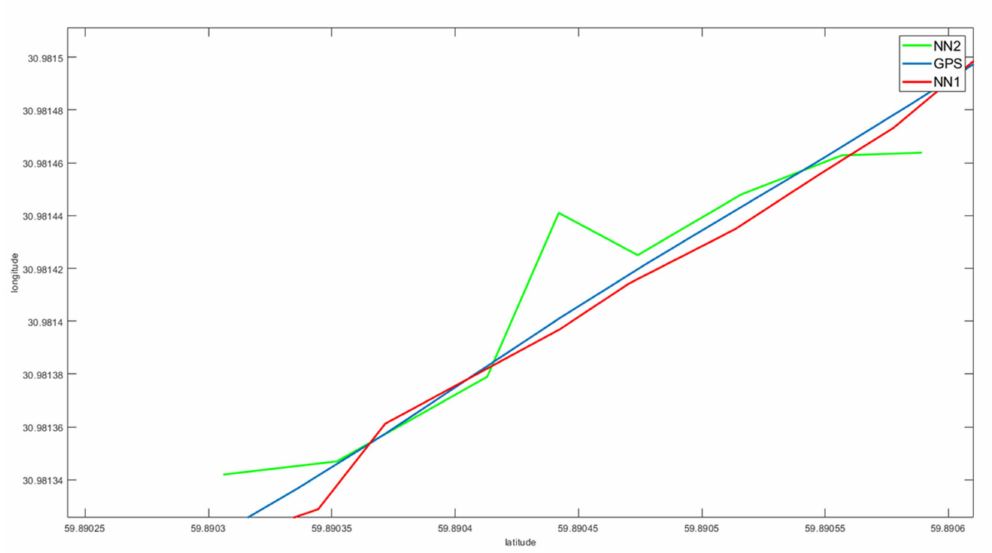
Figure 10. Comparison of the trajectories predicted by the considered neural networks with the reference trajectory on the straight section of the path.